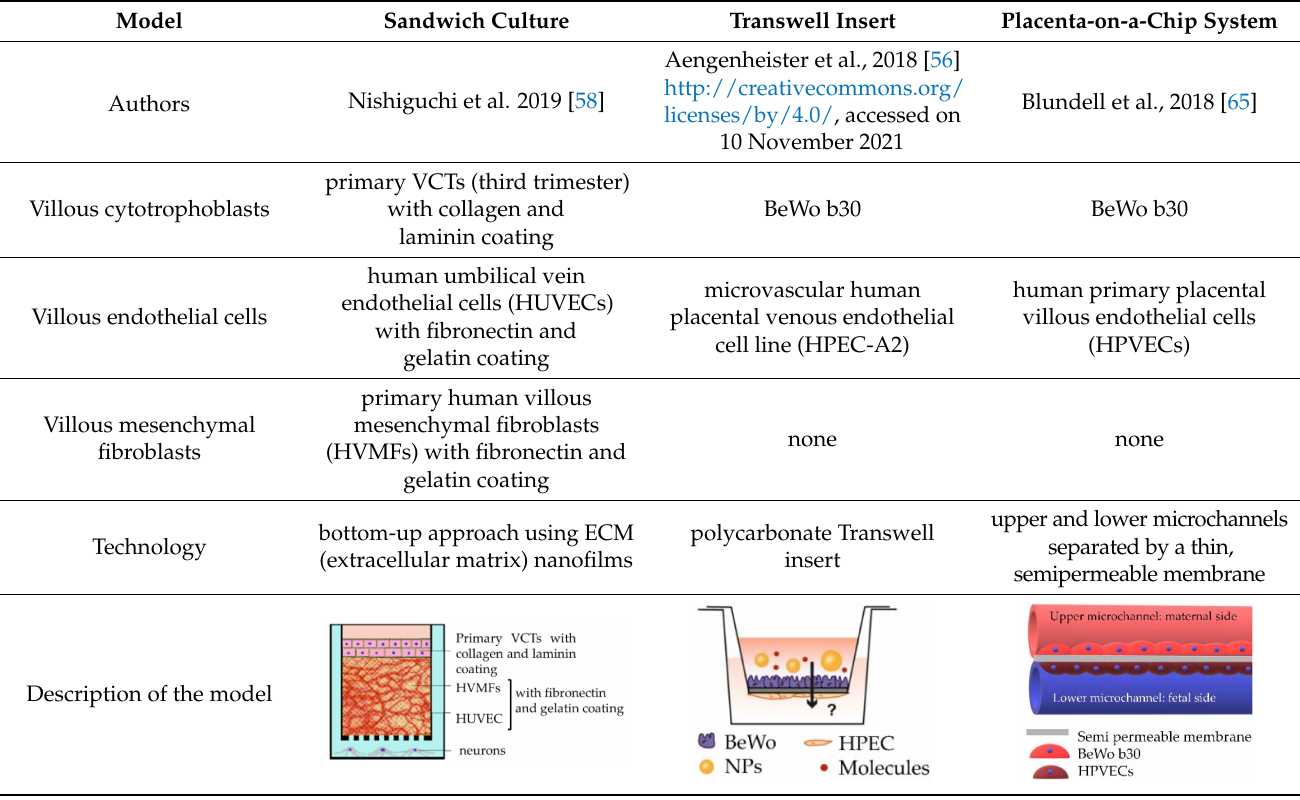
Table 2. The main co-culture models (reproduced after Nishiguchi et al. [58], Aengenheister et al. [56], Blundell et al. [65]).